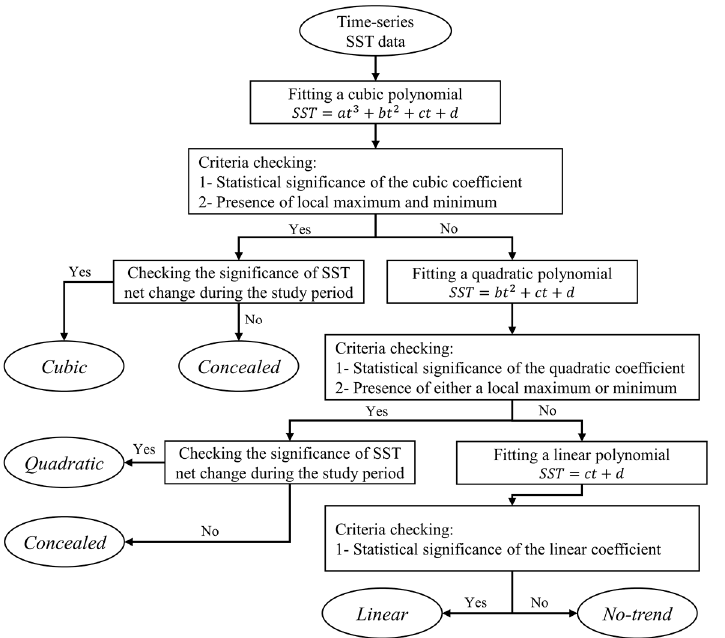
Figure 2. Flowchart of the PolyTrend algorithm implemented to examine the sea surface temperature (SST) trend of the Baltic Sea (after Jamali et al. [22]).